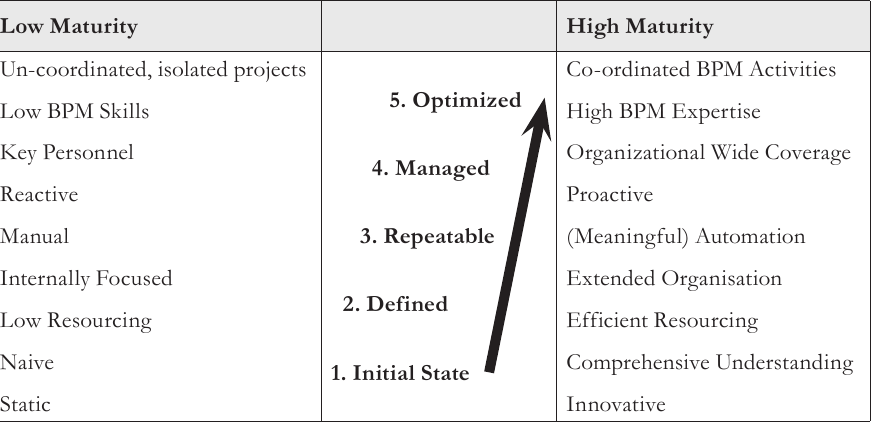
Tab. 1 – Business process maturity. Source: Paulk et al,